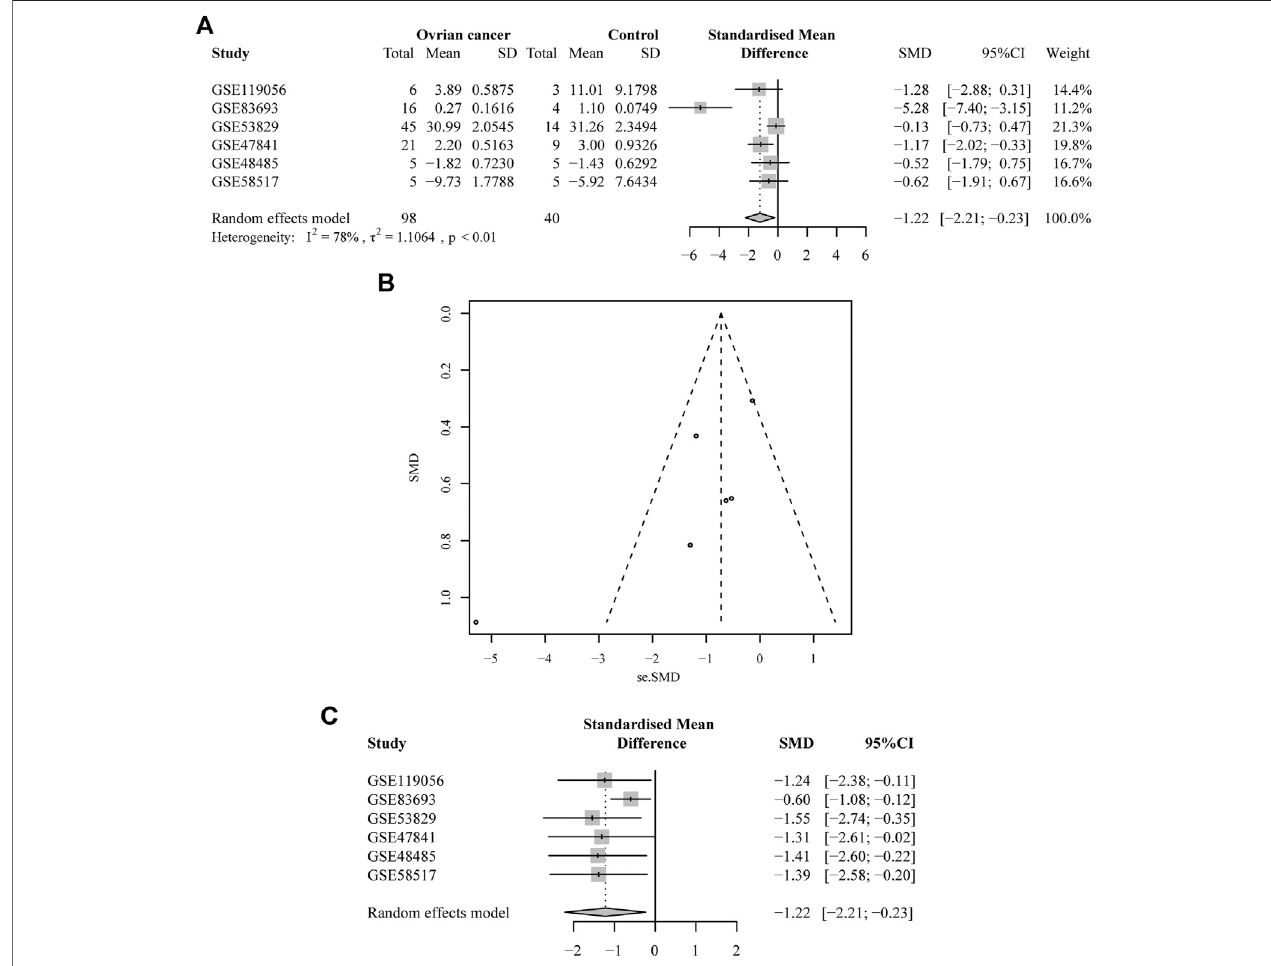
FIGURE3| Acomprehensivemeta-analysisoftheexpressionof miRNA-1827 fromthecollectedmicroarrays. (A) TheforestplotforthepooledSMDof − 1.22(95% CI: − 2.21, − 0.23) with a degree of heterogeneity (I 2 (cid:2) 78%, p < 0.01). (B) The funnel plot for assessing the publication bias of the GEO datasets by Begg ’ s test with p (cid:2) 0.09. (C) The sensitivity analysis for the GEO microarray results.